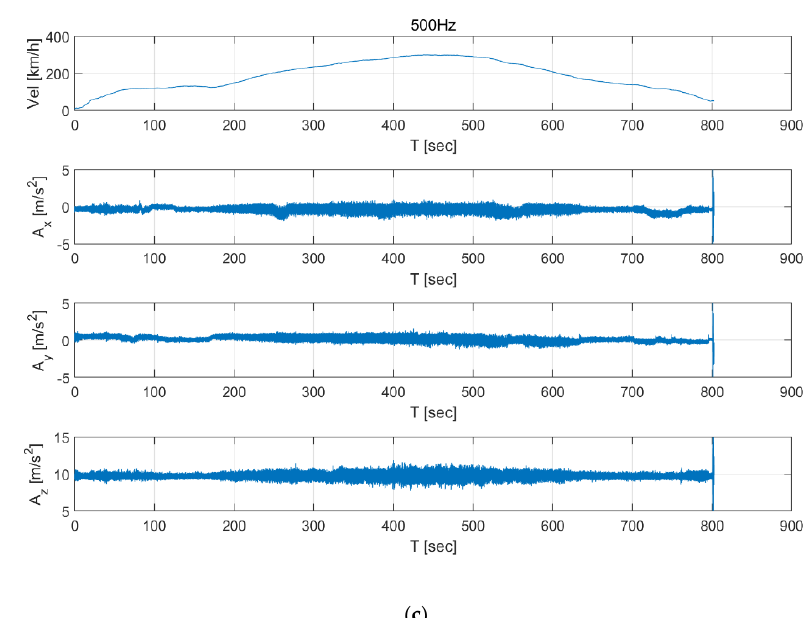
Figure 1. Korea Train Express KTX Data. ( a ) Travel route of the train for which train vibration data was collected. ( b ) Acceleration data collected from the installed vibration sensor. ( c ) Acceleration data collected from an Android smartphone located in the train car.